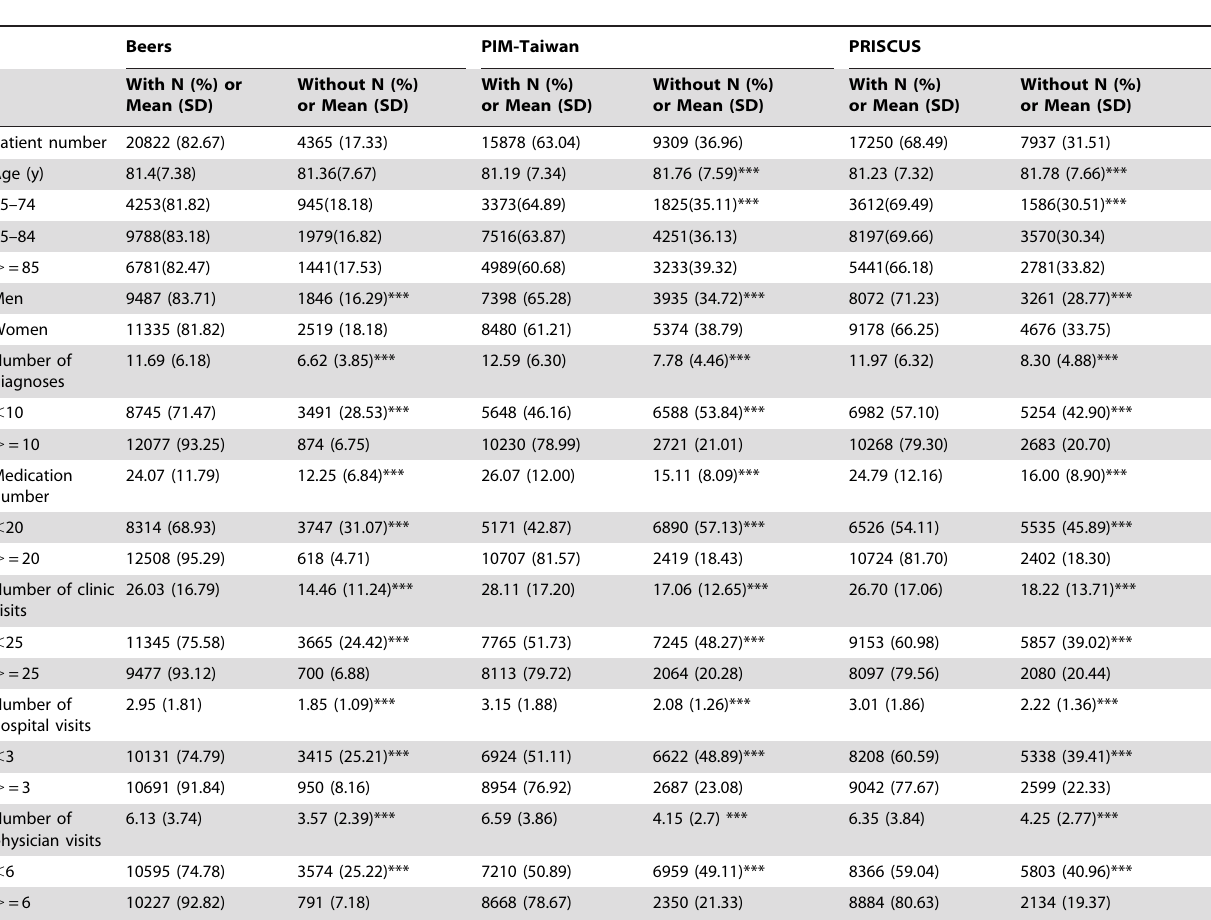
Table 3. Patient-level bivariate analysis (N =25187) by the presence of least one PIM according to the three sets of potentially inappropriate medication